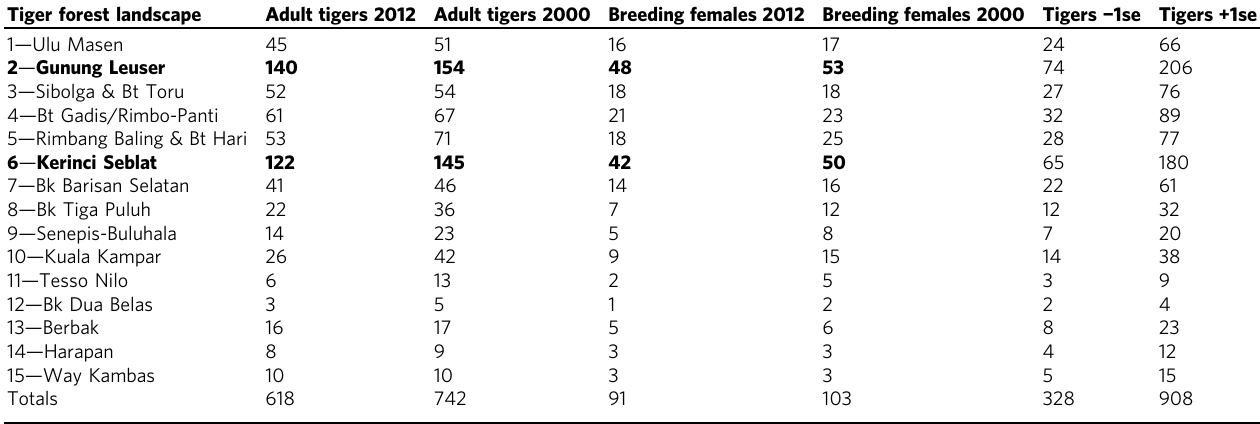
Table 3 Sumatran tiger population estimates in 2000 and 2012 Tiger forest